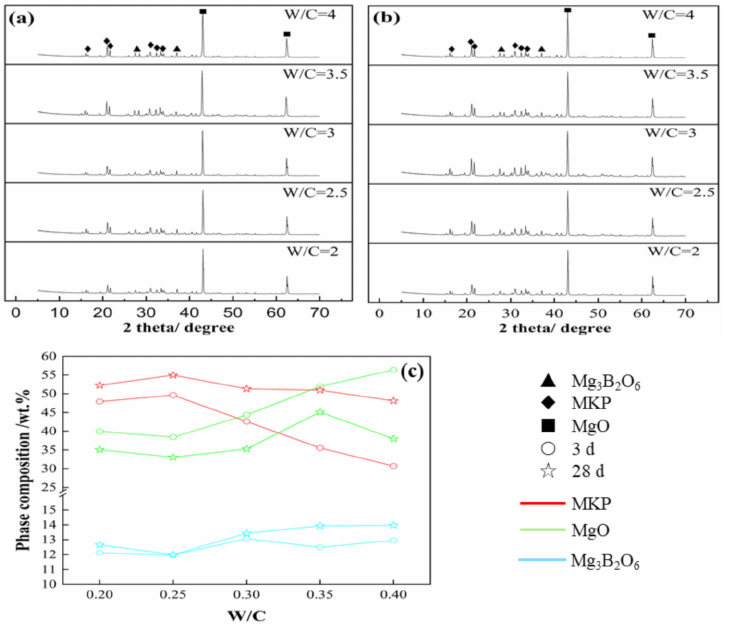
Figure 6. Influence of W/C ratios on the phase composition of SLMKPC: ( a ) After 3 d of curing, ( b ) after 28 d of curing, ( c ) TOPAS quantitative analysis of the phase compositions of SLMKPC at different W/C